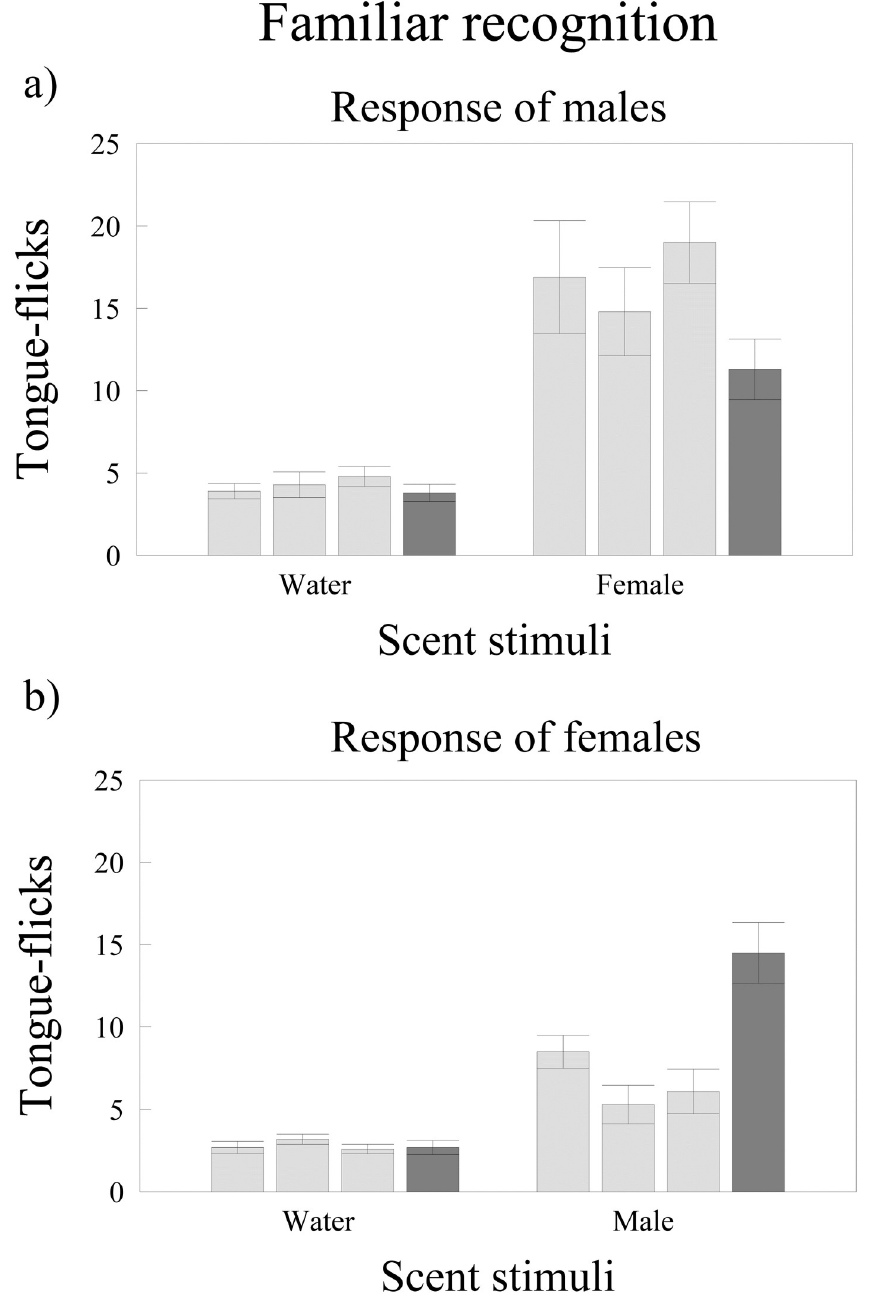
Fig 2. Familiar recognition in T . wiegmanni amphisbaenians. Number (mean ± SE) of directed tongue-flicks emitted by a) male and b) female amphisbaenians in 60 sec in response to odor stimuli presented on cotton swabs. For each treatment, we made three habituation trials (light grey) with swabs bearing water or scent from the familiar partner (the female or the male of each pair for the responding male or female of the same pair respectively) followed by a dishabituation trial (dark grey) with swabs bearing water or scent of an unfamiliar female or male.